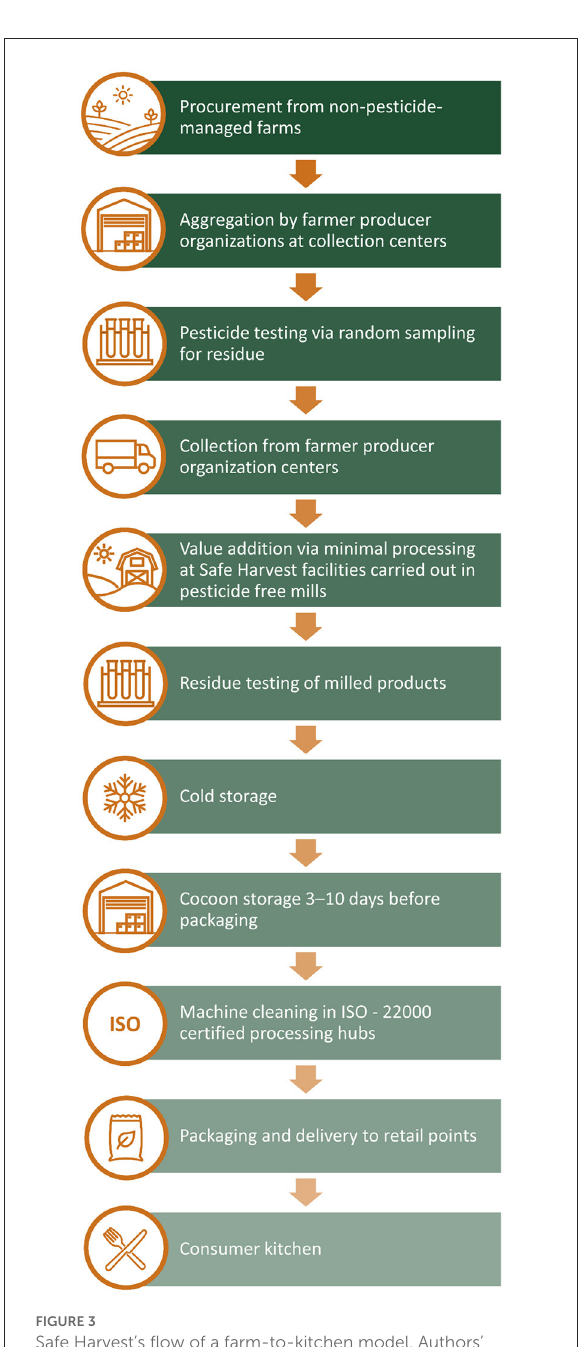
FIGURE3 Safe Harvest’s flow of a farm-to-kitchen model. Authors’ creation based on Safe Harvest website, inputs from interviews and Anil